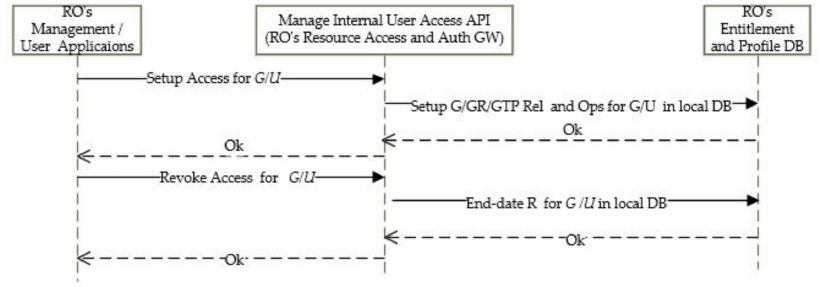
Figure 6. Setup/revoke access for Org’s internal groups ad users.